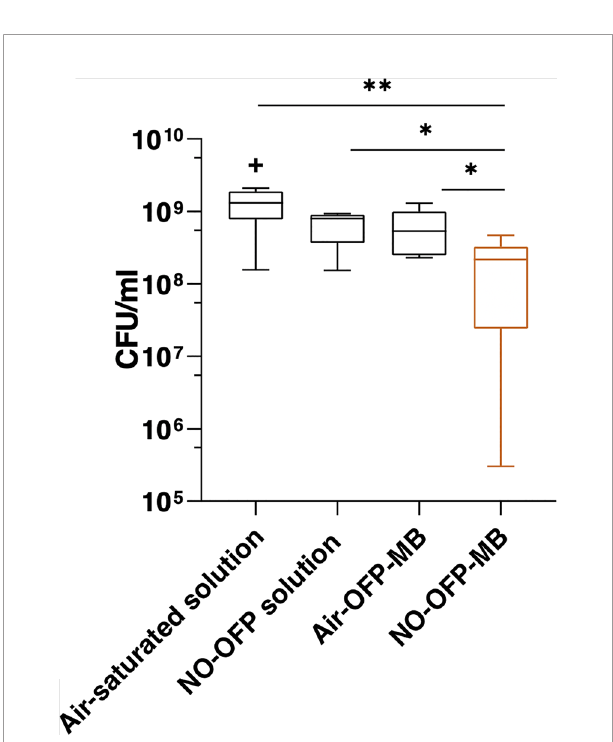
FIGURE 11 | Measurement of bacteria colony forming units (CFU) after treatment with the solvent only (n = 10), NO-OFP-saturated solvent 9:1 v/v, (n = 9), air-OFP-MB 9:1 v/v, (n = 12), and NO-OFP-MB 9:1 v/v, (n = 12). The horizontal lines represent the median, the boxes represent the interquartile range, the whiskers represent 1.5-times the interquartile range. The symbols “ * ” and “ ** ” represent p -values < 0.05, and < 0.01, respectively. The “ + ” sign represents a data point that lies outside the interquartile range by a factor > 1.5. NO-OFP-MB, Nitric oxide and octa fl uoropropane